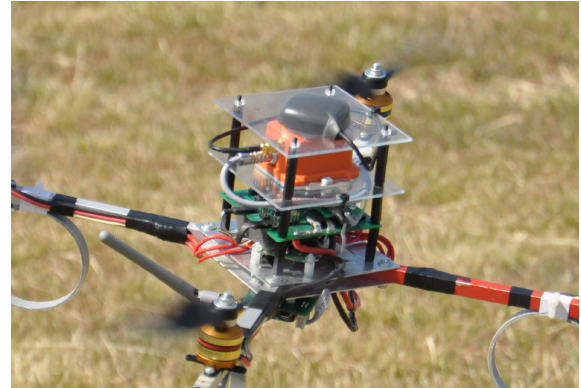
Figure 6. UAV control board and the other